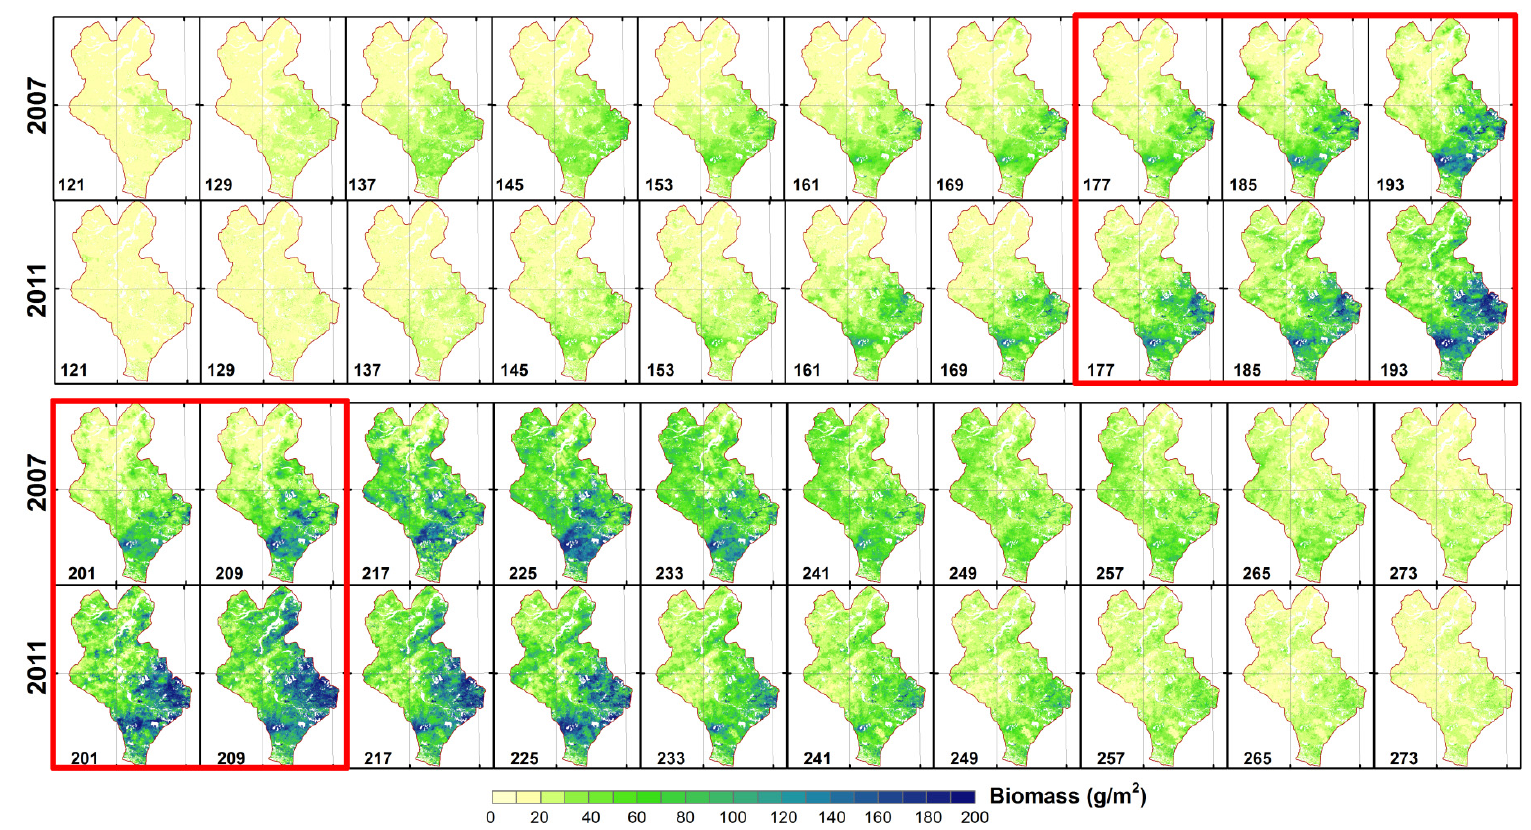
Figure 6. Spatial distribution of biomass in 2007 and 2011 for each 8-d intervals during the growing season.